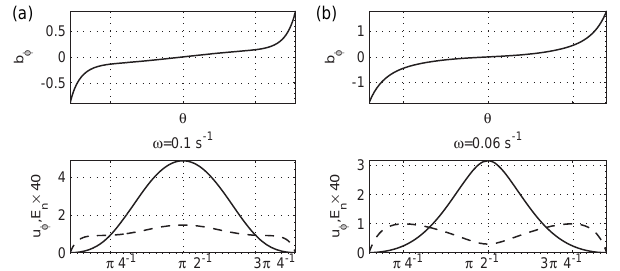
Figure 4. Wave forms of the fundamental mode ( L = 6) on the (a) noon and (b) midnight meridional plane ( φ = 0 and π ), respec- tively. Dashed line denotes the electric field profile, with a multi- plication by 40. All units are arbitrary. The corresponding eigenfre- quency is denoted in the middle of each subplot.